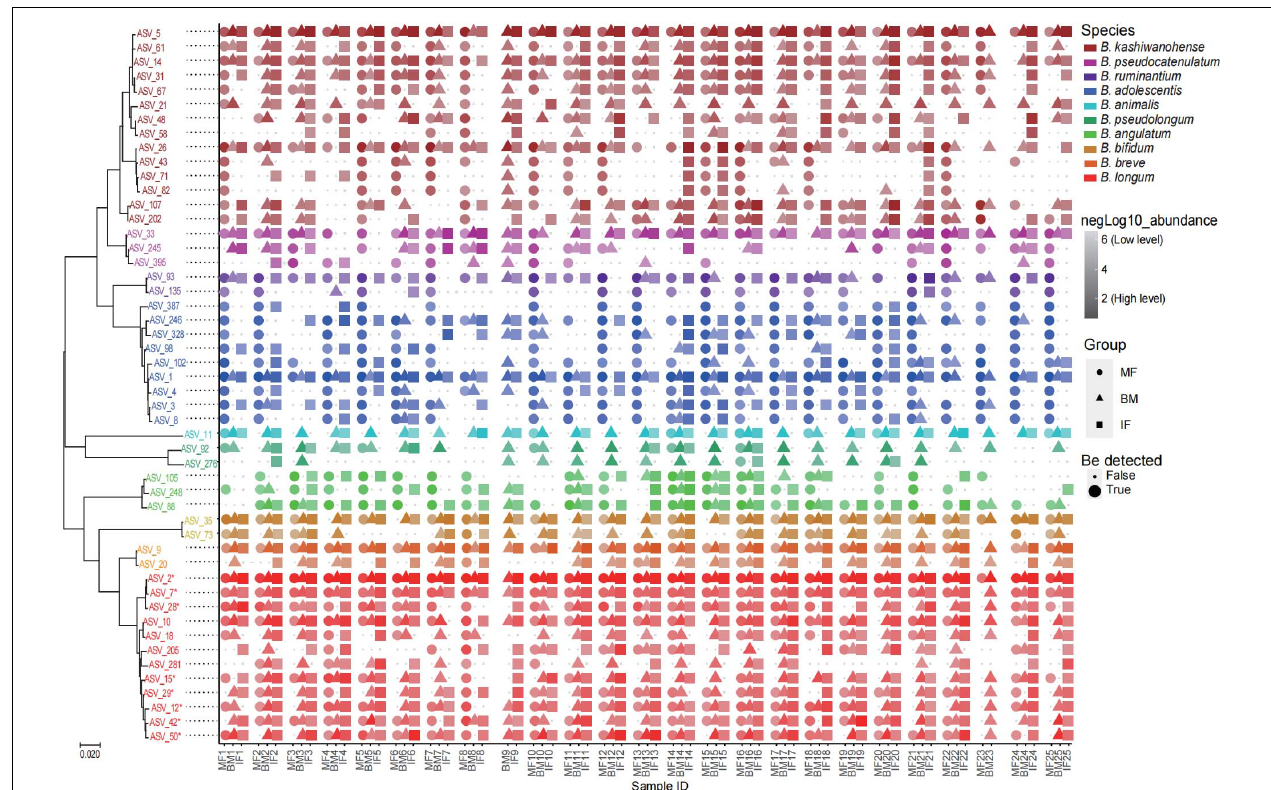
FIGURE 6 | Phylogenetic tree of the 50 dominant ASVs and their co-occurrence in samples from 25 mother–breast milk–infant triads. The color of the text in the tree represents different bifidobacteria species. The color gradient of symbols represents the level of logarithm of relative abundance (the darker the color, the higher the relative abundance), the shapes represent different ecosystems, and the size is the logical value of whether the ASV can be detected in the sample. * B. longum subsp. infantis